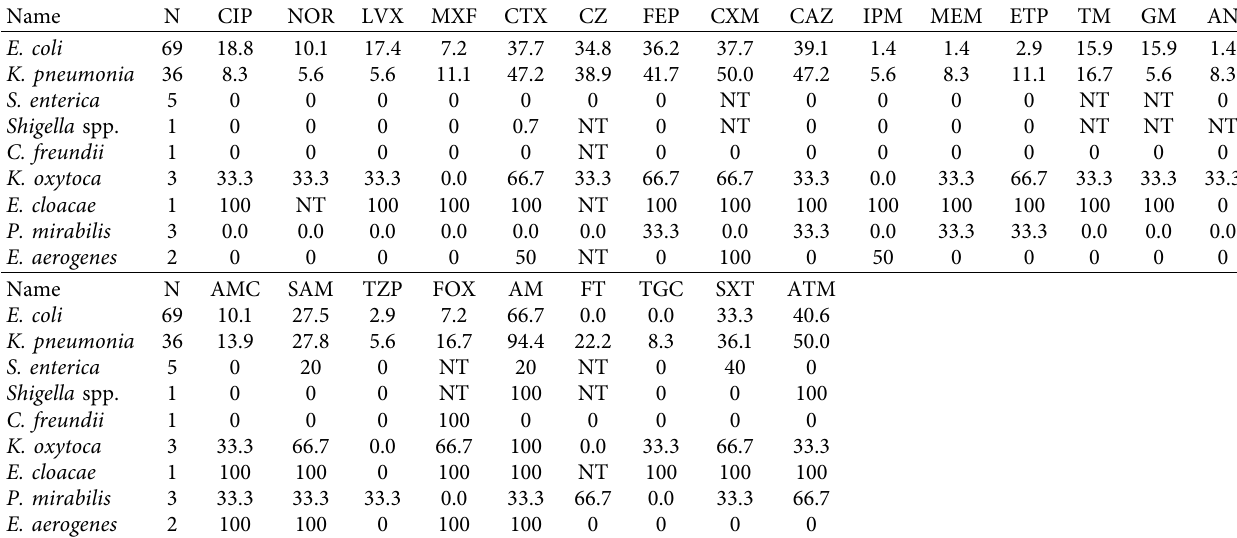
Table 2: Percentage of antimicrobial resistance patterns of Enterobacteriaceae isolated from different clinical